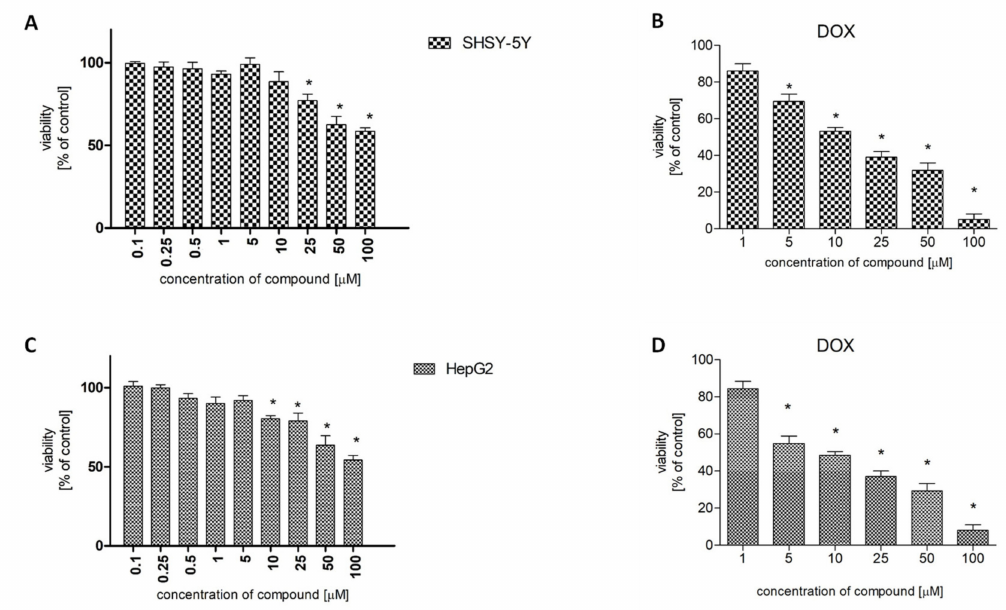
Figure 5. Viability of SHSY-5Y and HepG2 cells treated with compound 18 in the MTT test; doxorubicin (DOX) was used as reference control. ( A ): compound 18 (SHSY-5Y), ( B ): DOX (SHSY-5Y), ( C ): compound 18 (HepG2), ( D ): DOX (HepG2). Graphs represent the viability of cells as a % of control (non-treated cells). Values represent means ± SEM of three independent experiments. Statistical significance (*) vs. control was determined using the Mann-Whitney test, p <